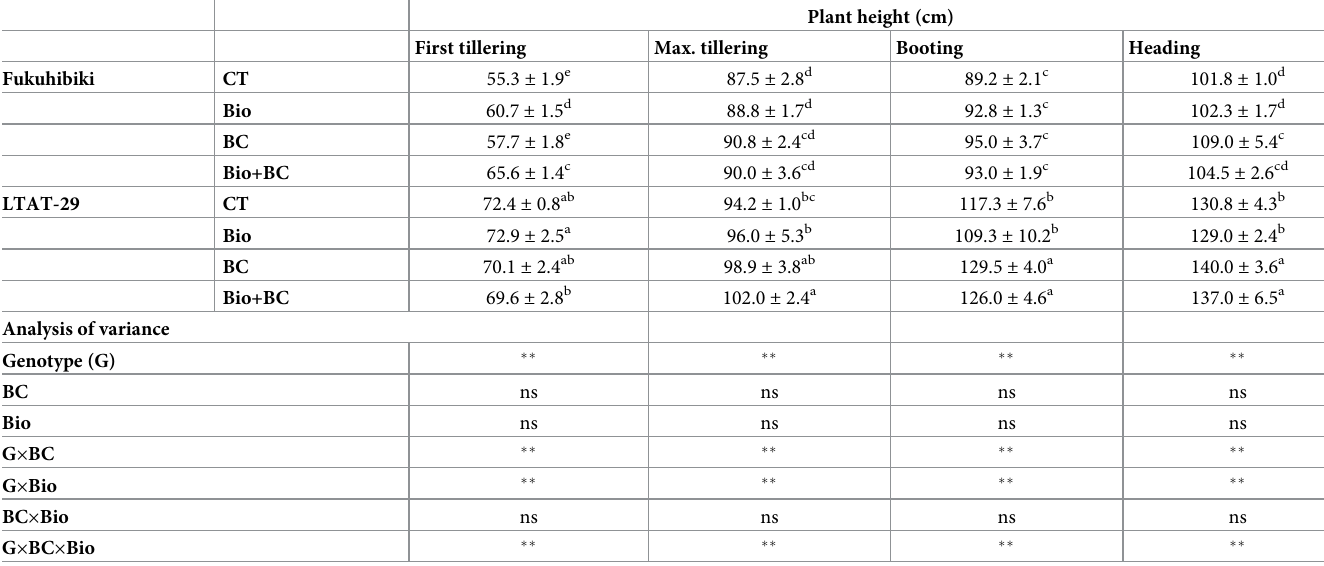
Table 3. Effect of TUAT-1 biofertilizer, biochar, and their combination treatments on plant height (cm) at different growth stages of two rice